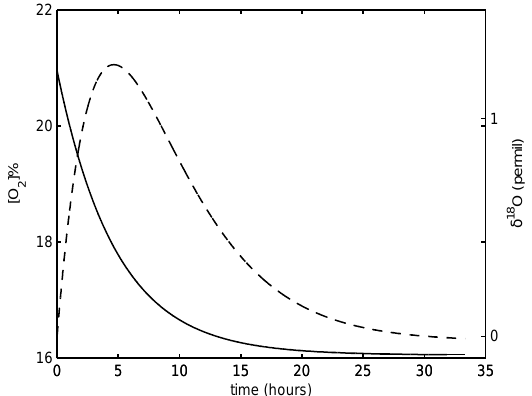
Fig. 1. Modelled O 2 concentrations (solid line) and δ 18 O values (dashed line, versus atmospheric air) in the stem chamber, for a model run with D stem